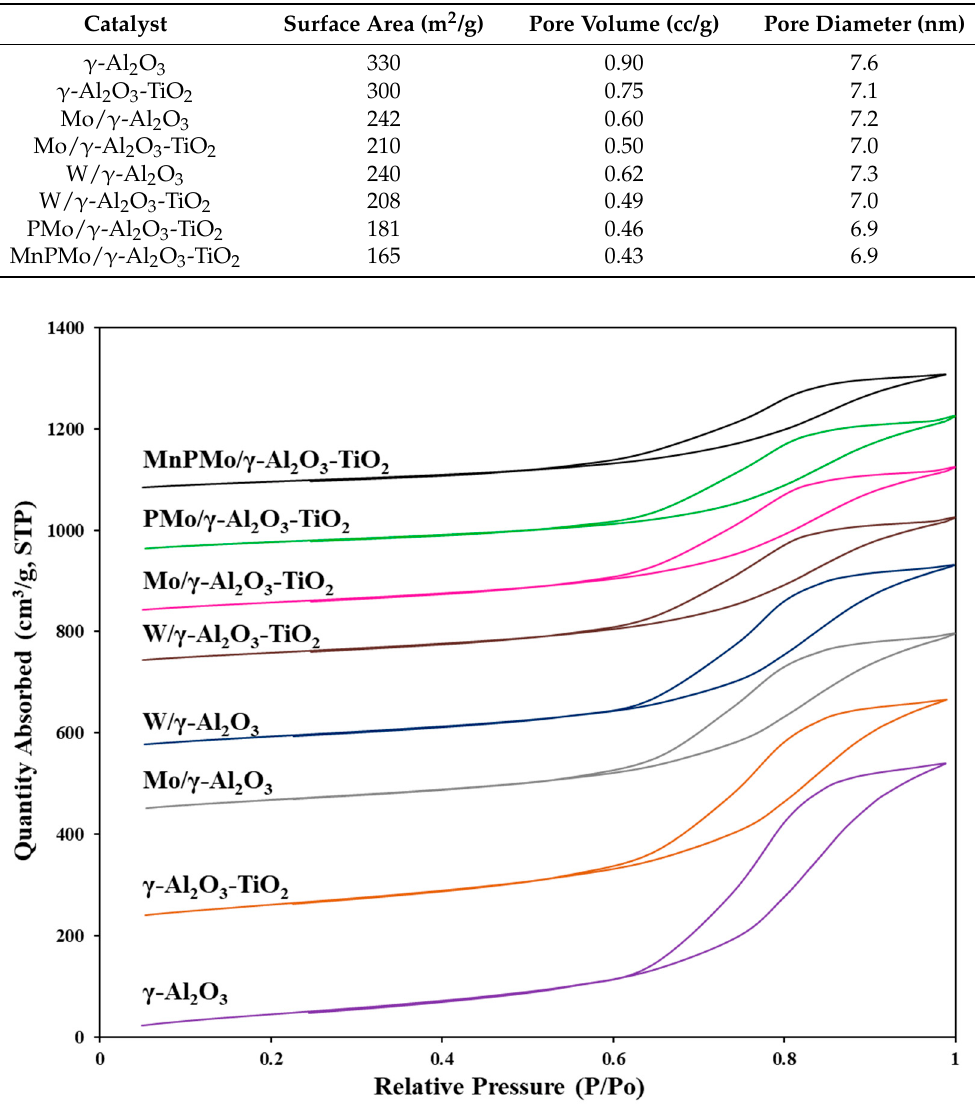
Figure 2. N 2 adsorption-desorption isotherms for all materials. Table 1. Textural properties of the catalysts used for oxidative desulfurization and denitrogenation. (error ±3.0%).